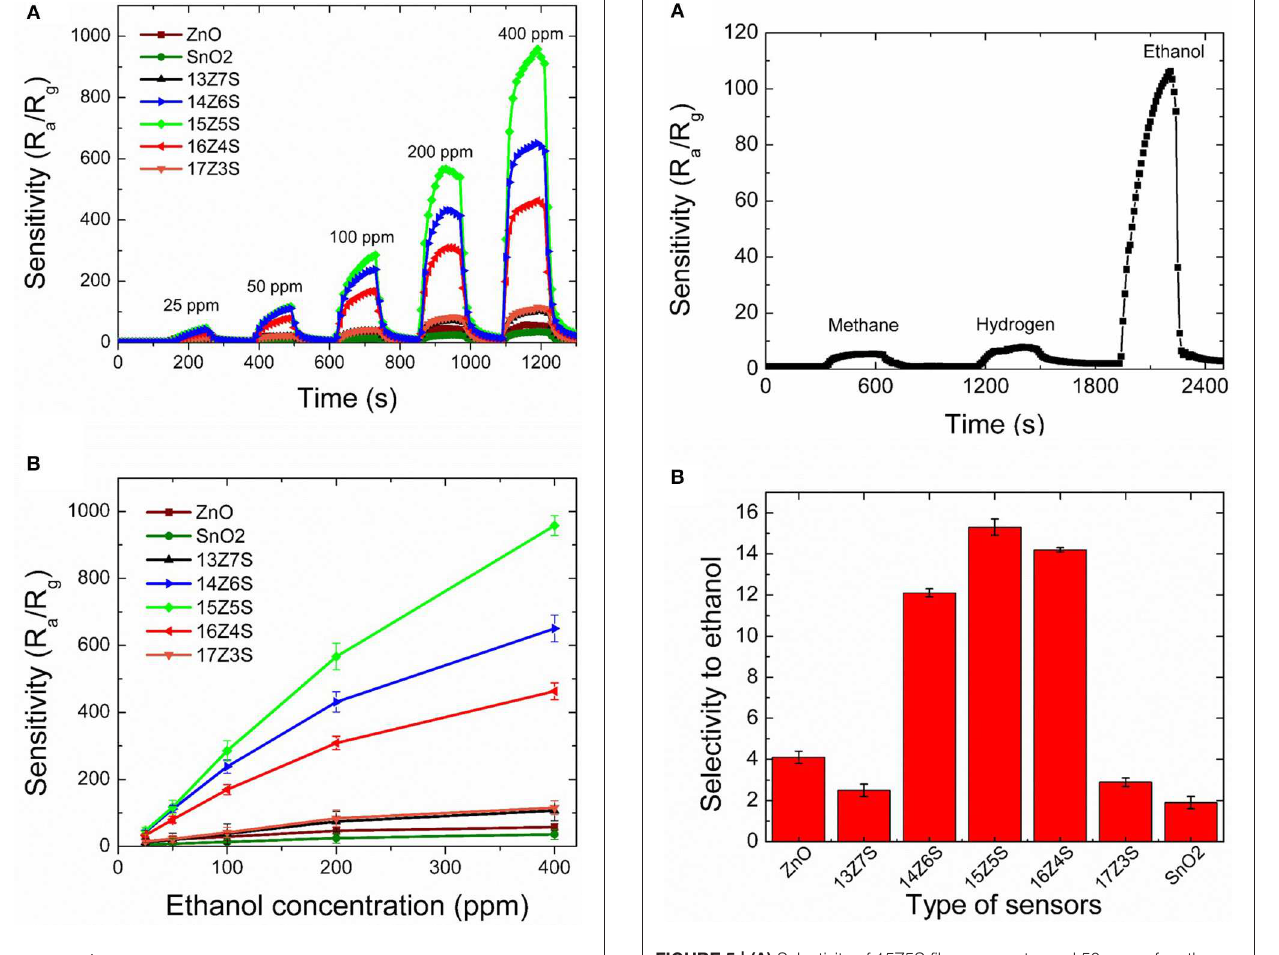
Frontiers in Materials |